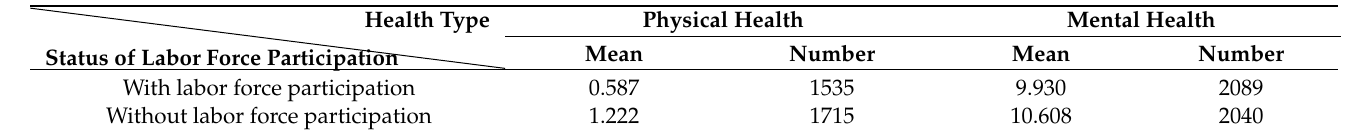
Table 2. Health of the elderly under different labor force participation